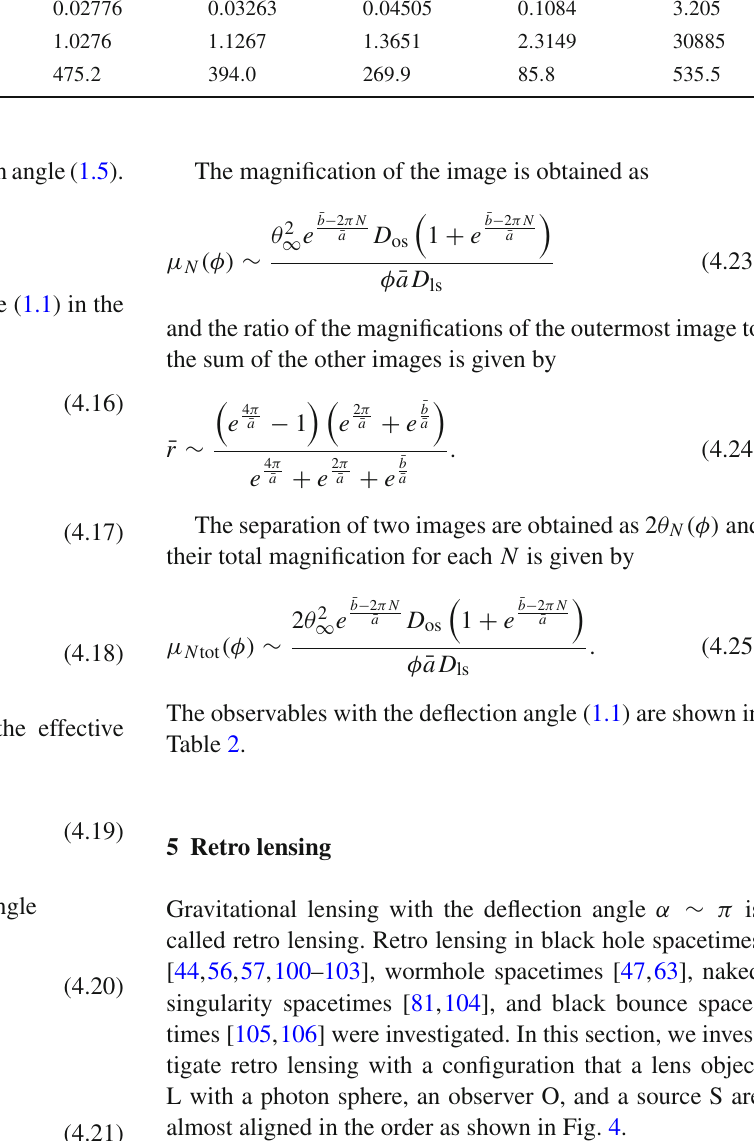
D ol = D ls = 16 . 8 Mpc, and the source angle φ = 1 arcsecond. The